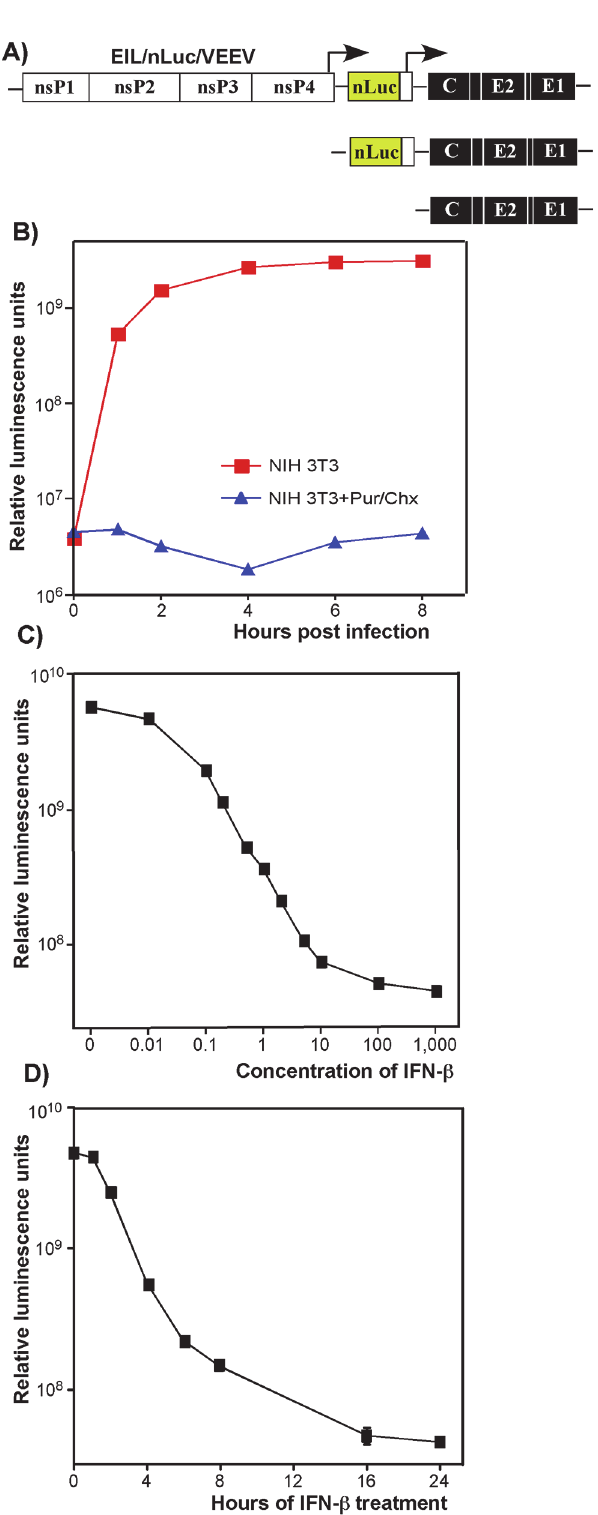
Fig 2. Type I IFN pretreatment inhibits nLuc expression in vertebrate cells in time- and concentration- dependent mode. (A) The schematic representation of EIL/nLuc/VEEV genome and encoded SG RNAs. (B) NIH 3T3 cells were infected with purified EIL/nLuc/VEEV at an MOI of 10 PFU/cell. After 1 h incubation at 4°C, cells were washed with cold PBS, and then incubated at 37°C in complete media. At the indicated time